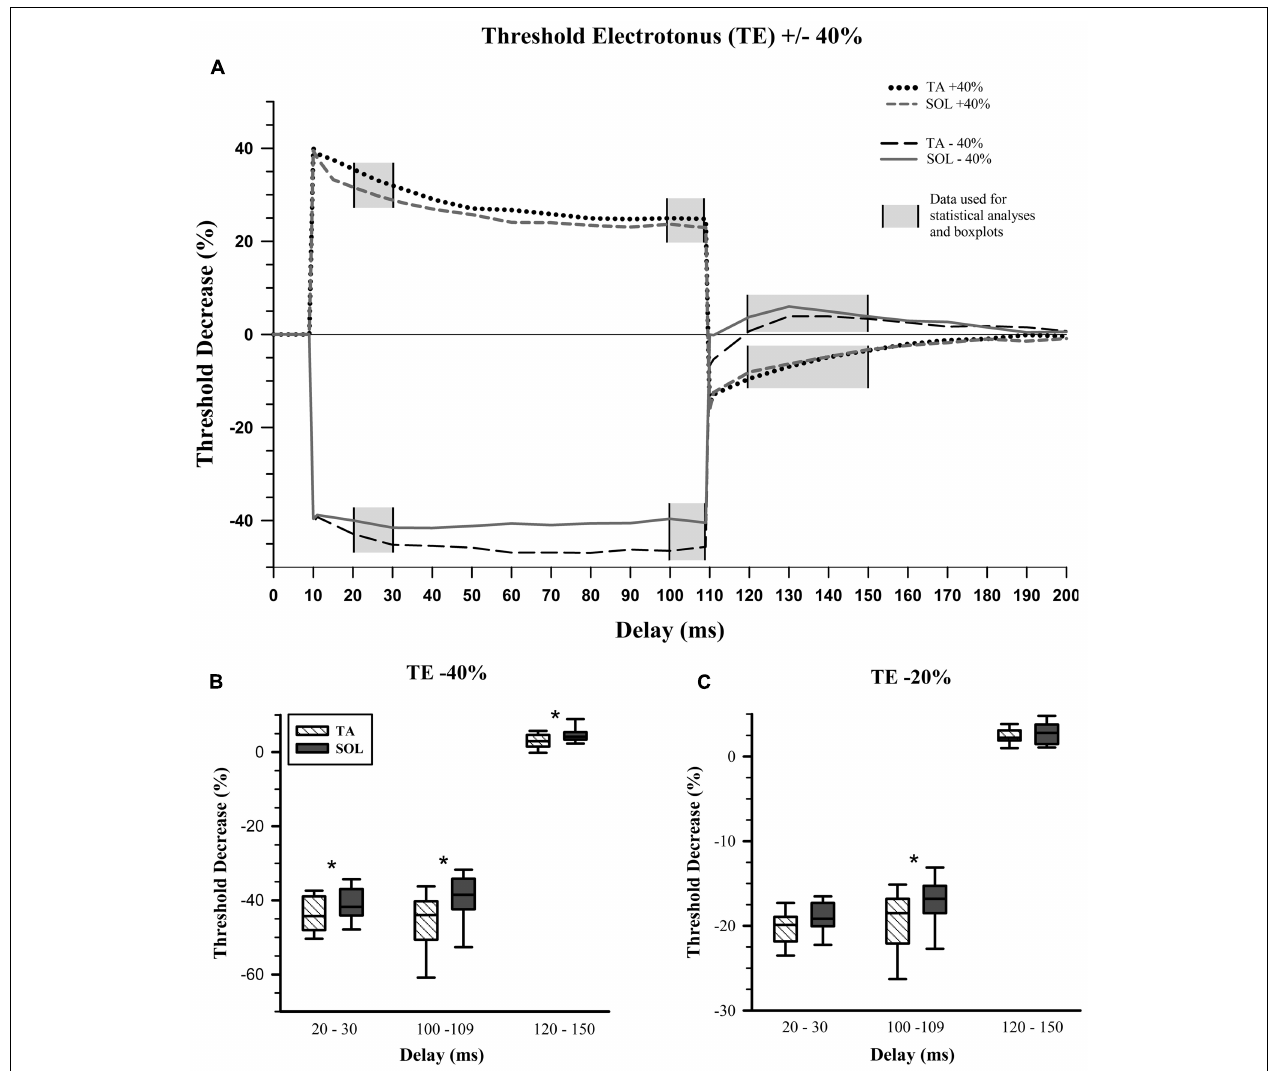
hatched boxes, SOL in gray boxes.Wilcoxon signed-rank tests, which are paired comparisons, show a statistically significant increase in median “Threshold Decrease (%)” for SOL compared toTA axons at all delays. (C) Percent change in threshold for the hyperpolarizing 20%TE condition. There is a statistically significant increase in median threshold change for SOL compared toTA axons, only at the end of the hyperpolarizing condition pulse, i.e., 100–109 ms. ∗ p <